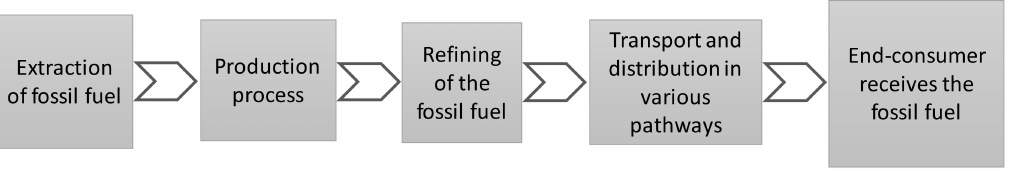
Figure 1. Life cycle processes of the fossil